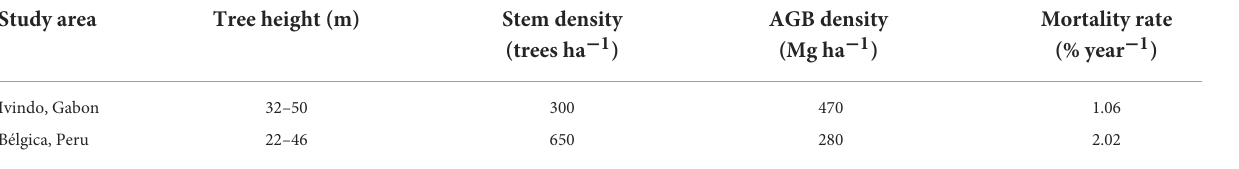
TABLE 1 Forest structure characteristics of each study site. Study